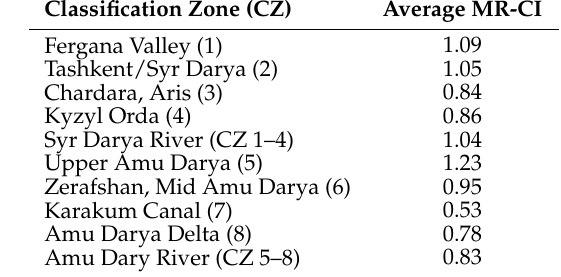
Table 7. Spearman’s rank correlation coefficient (Spearman’s rho) for the correlation between the upstream runoff formation and intensity indicators cropping intensity (CI GRID ) and percentage of and fallow frequency (PF) in the eight classification zones (CZ), and the entire catchment.